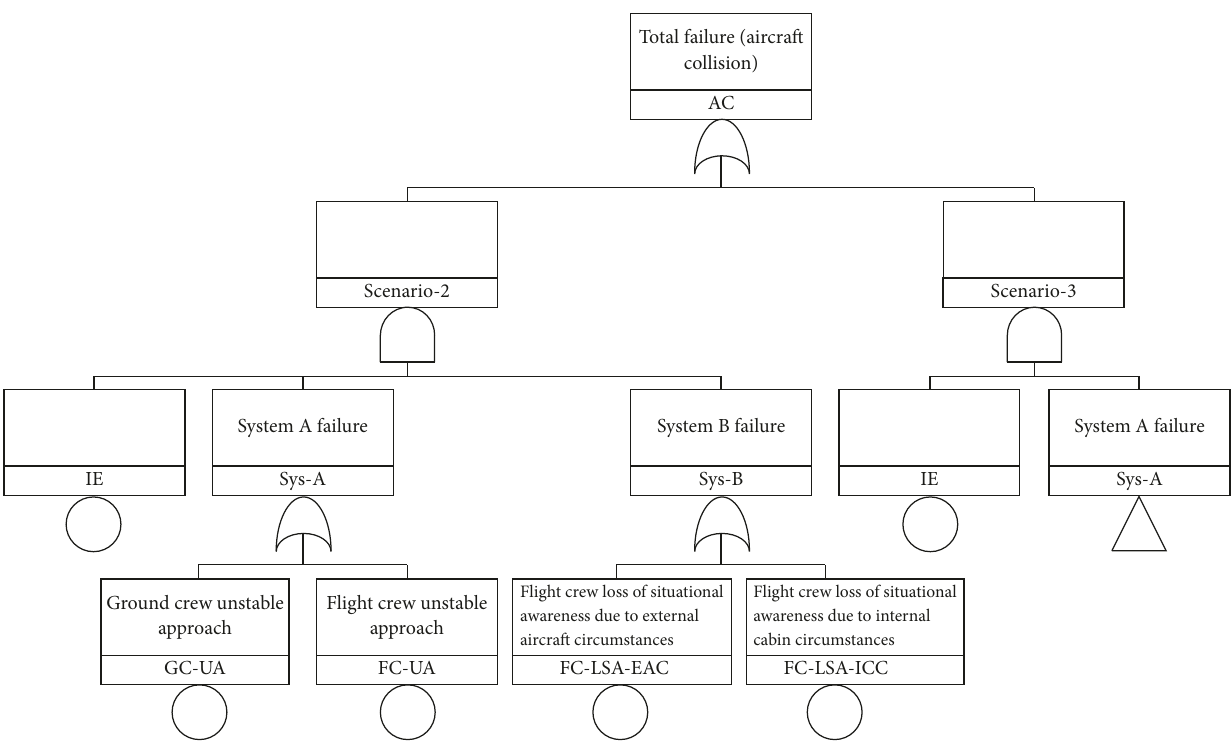
Figure 4: Example of integrated FT for aircraft collusion (entire system